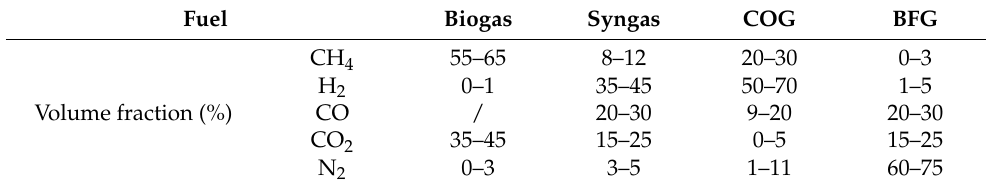
Table 2. Typical composition ranges of